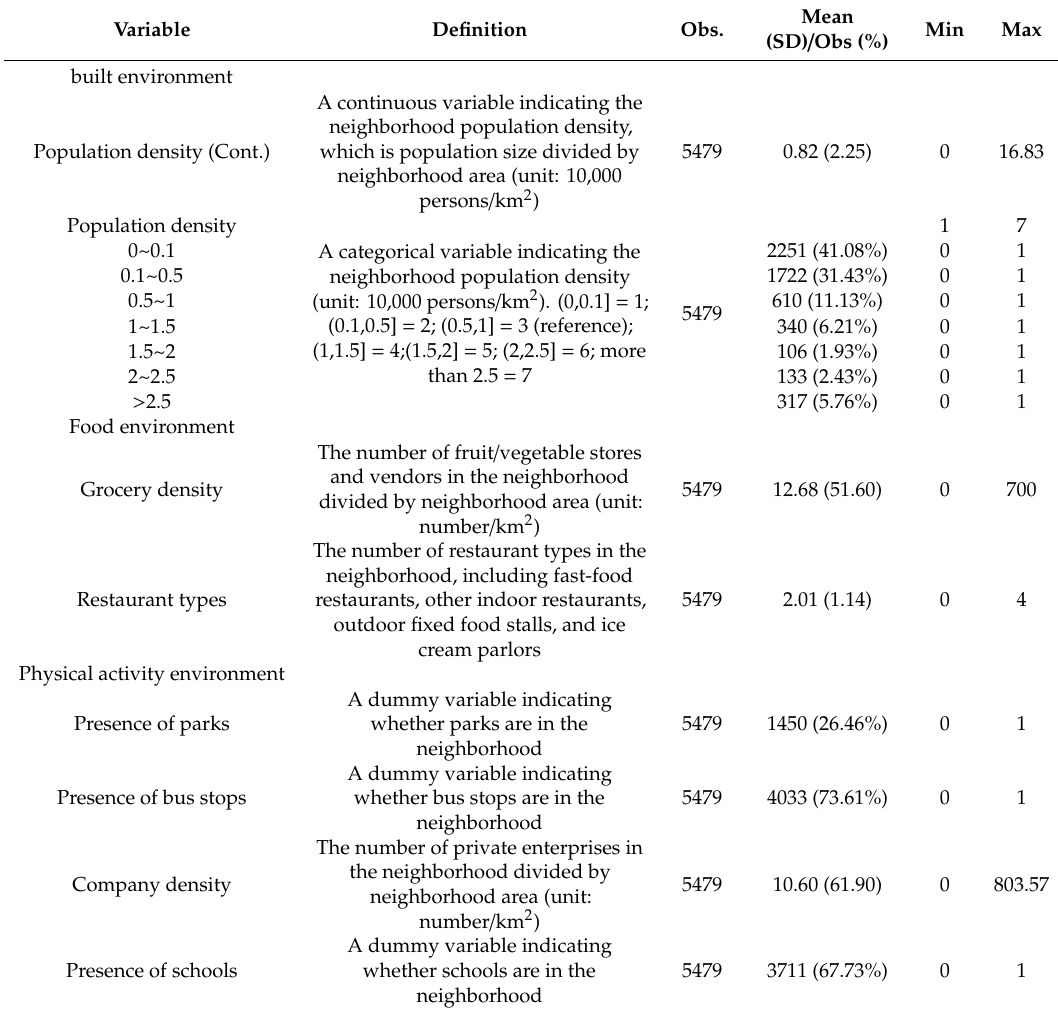
Table 1. The definition and descriptive characteristics of the built environment, socio-economic attributes, respondents’ attitudes, and possible